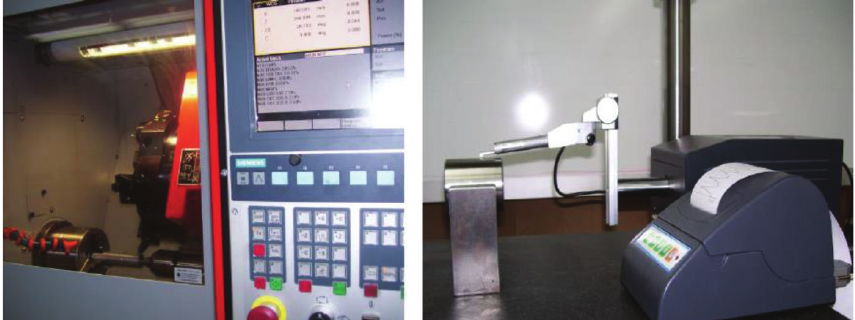
Figure 1: Test rig for turning and surface roughness measurement.